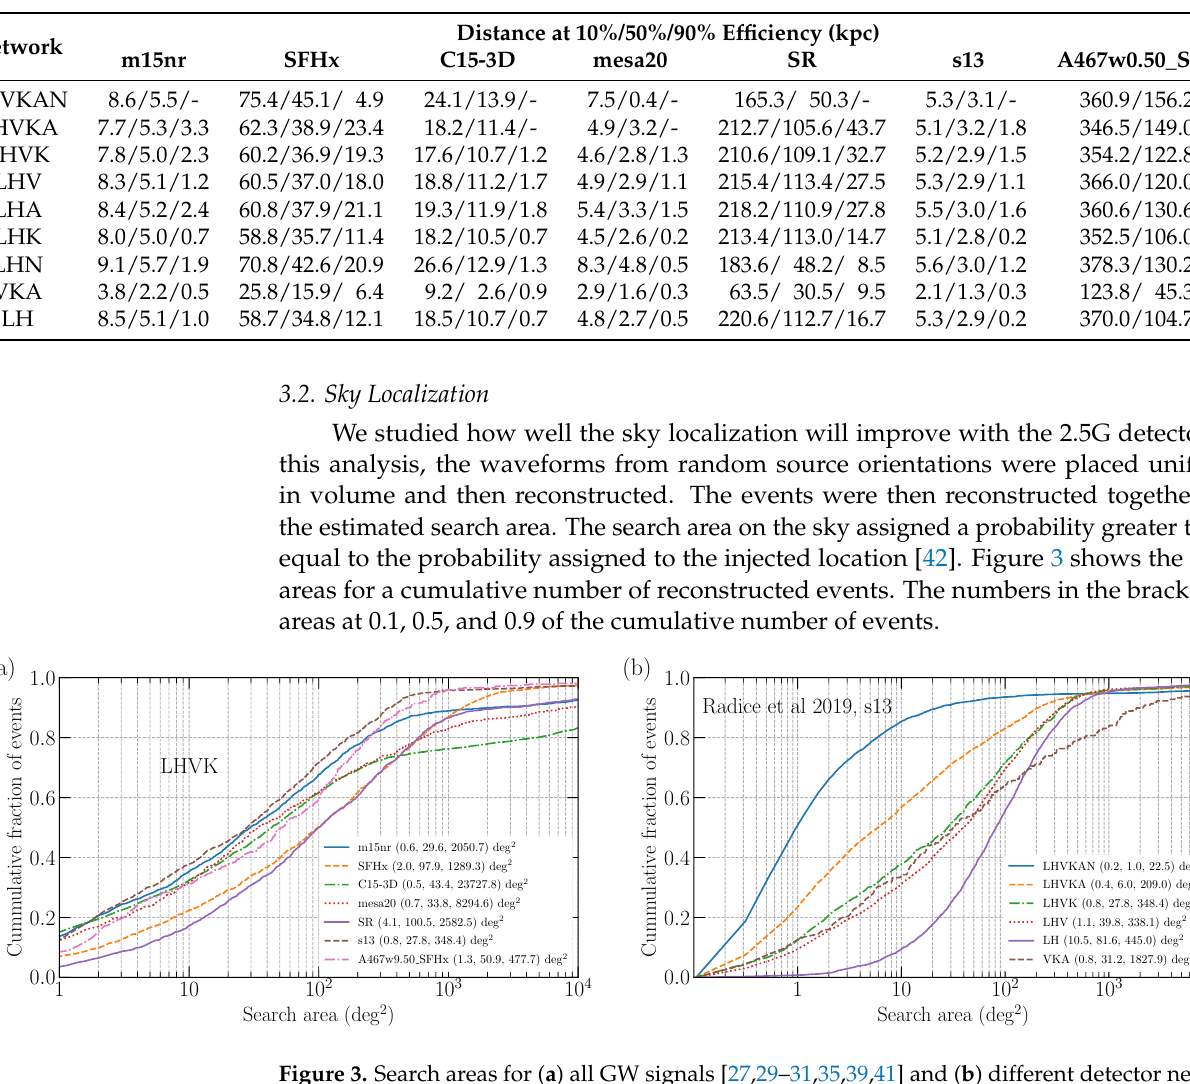
Figure 3. Search areas for ( a ) all GW signals [27,29–31,35,39,41] and ( b ) different detector networks for s13 model [29]. The search area is comparable between GW morphologies. Adding detectors to the network significantly reduces the search area. Numbers in brackets are 0.1, 0.5 and 0.9 of the cumulative number of